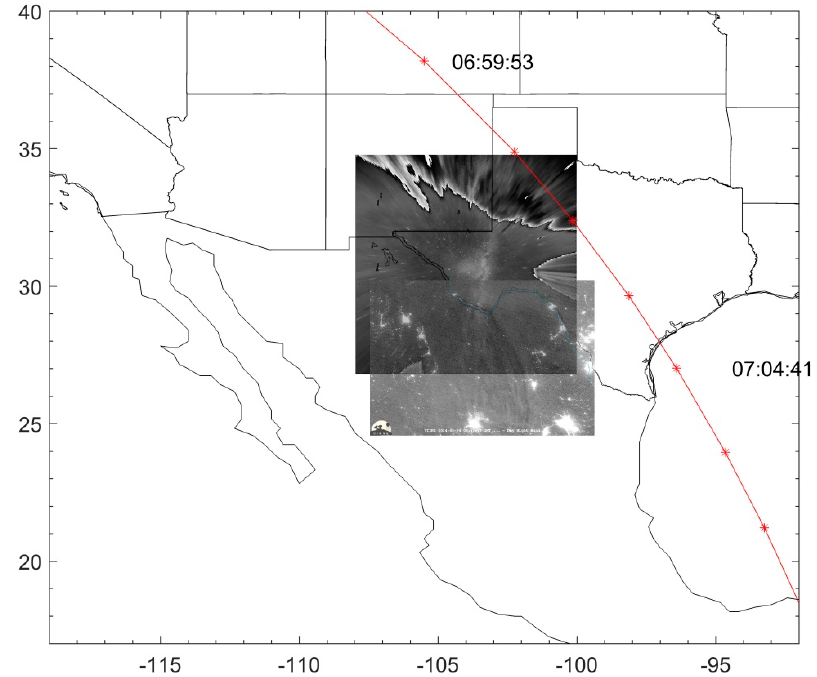
Figure 5. TIMED/SABER instrument descending footprints in the field of view during the bore event on 4 May 2014.